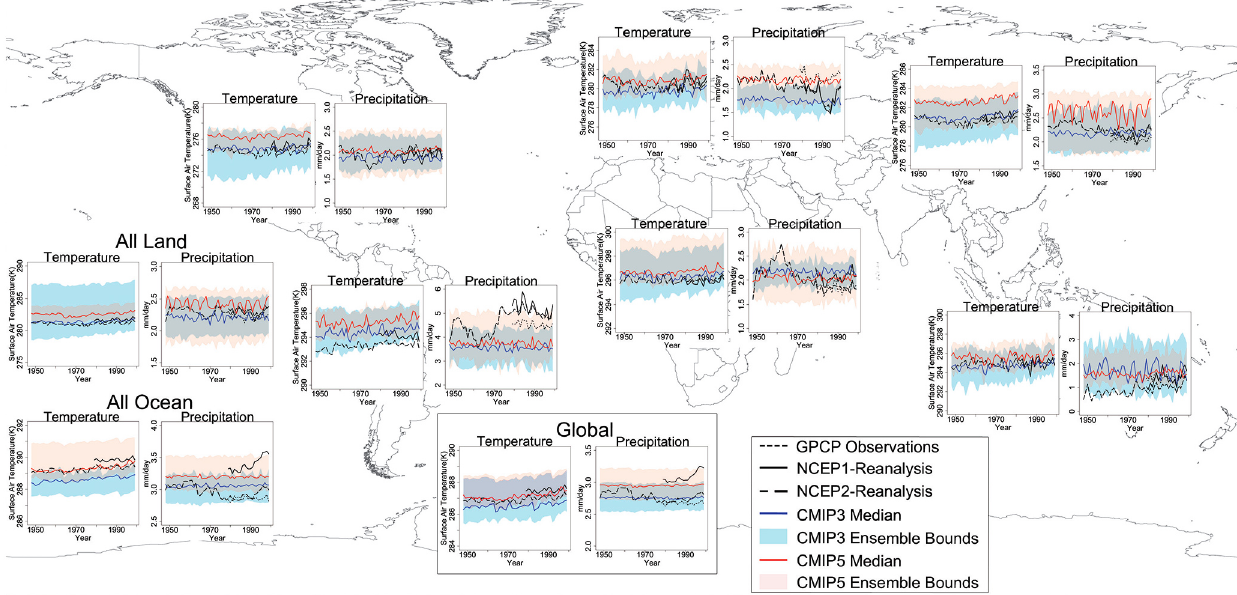
Figure 2. GCMs are designed to simulate the large-scale circulation of the atmosphere and its response to external forcing, and need to be evaluated from that perspective. However, adaptation, impacts and vulnerability (IAV) studies occasionally use GCM model simulations directly or after statistical and dynamical downscaling. Model-based assessments in the future need to ultimately rely on GCM projections. Nevertheless, relatively naïve utilization of GCM projections for IAV studies may yield non-informative or even misleading conclusions. This is illustrated though comparisons between the CMIP3 and CMIP5 climate model simulations at continental and global scales in terms of average temperature and precipitation. The two GCM-ensembles are evaluated against the observation-based National Centers for Envi- ronmental Prediction/National Center for Atmospheric Research (NCEP/NCAR, NCEP-1) and National Centers for Environmental Predic- tion/Department of Energy (NCEP/DOE, NCEP-1) reanalysis data. For precipitation, the Global Precipitation Climatology Project (GPCP) observational data is used in addition. Aggregate comparisons do not appear to suggest significant improvements of CMIP5 over CMIP3. While this does not necessarily imply a lack of improvement in CMIP5 over CMIP3 in terms of large-scale dynamics, this does suggest the need for caution when GCMs (with or without downscaling) need to be used for IAV